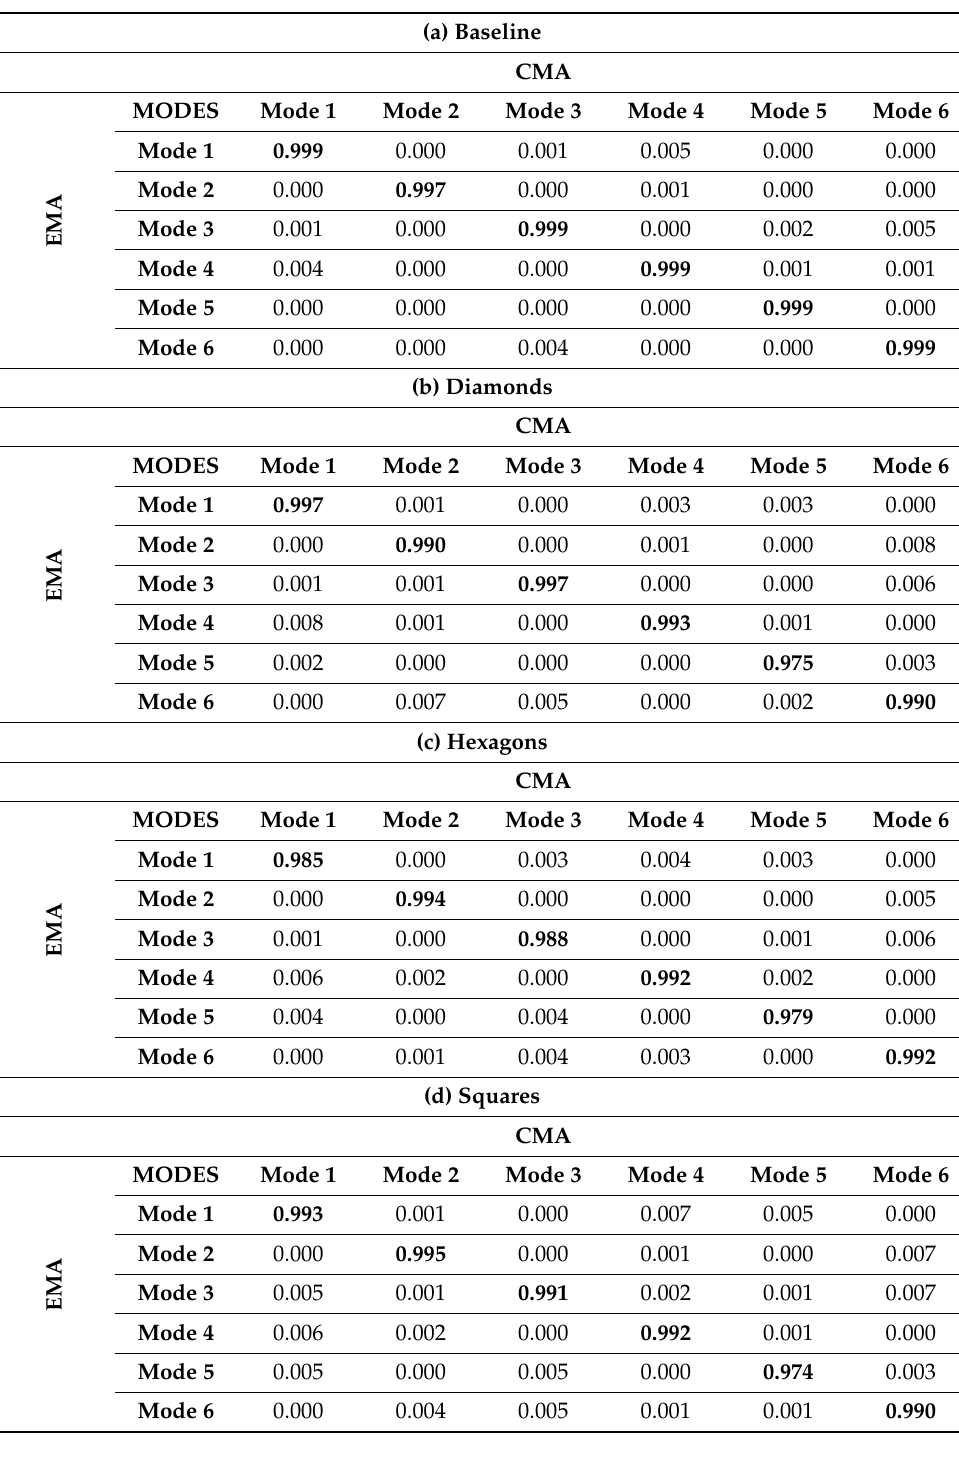
Table 2. MAC correlation between the EMA and CMA mode shapes for the first six